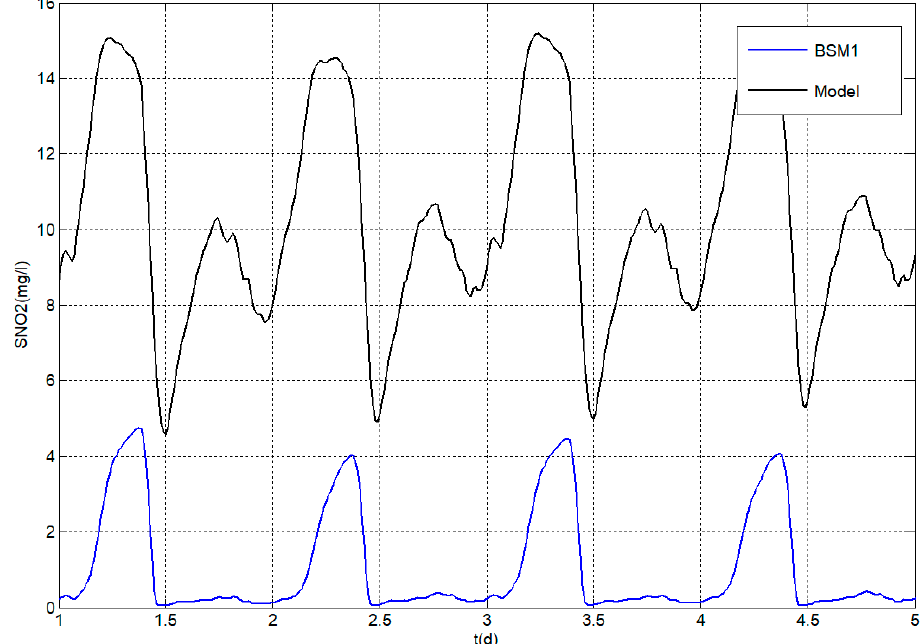
Figure A1. Comparison of the reduced model and BSM1 evolution of the nitrates concentration in the second anoxic reactor obtained in the open loop operation using the manipulated variables values that produce the nominal set points.